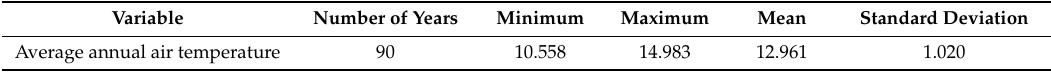
Table 1. Average annual air temperature at the Khiva weather station for